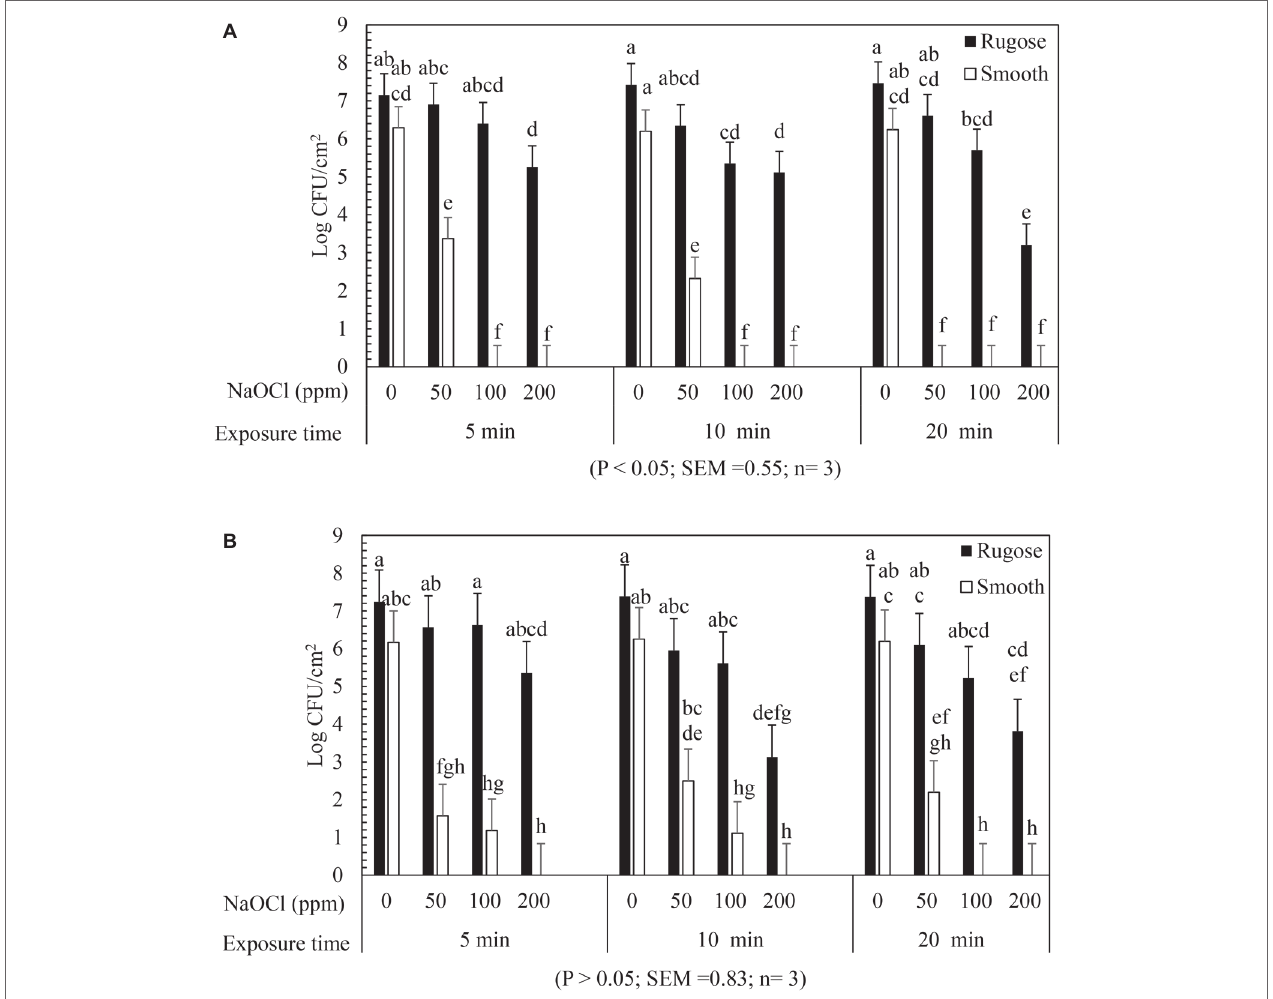
FIGURE 4 | Biofilm survival of S. Typhimurium ATCC 14028 and S. Heidelberg ATCC 8326 morphotypes on polystyrene surface after NaOCl treatment. Bars represents S. Typhimurium (A) and S. Heidelberg (B) biofilm survival at different NaOCl concentrations (50, 100, or 200 ppm in water) for different exposure times (5, 10, or 20 min). In (A) , three way significant interaction of factors was found for NaOCl concentrations, exposure time intervals and Salmonella morphotypes. In (B) , no significant interaction of factors found for NaOCl concentrations, exposure time and Salmonella